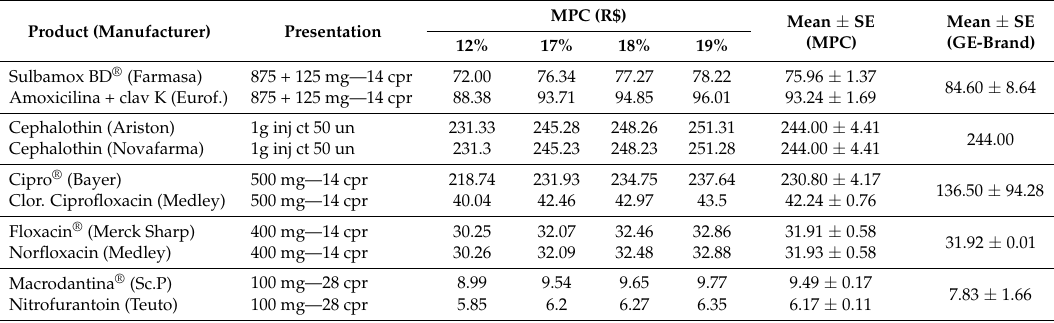
Table 4. Cost of antibiotics at different tax